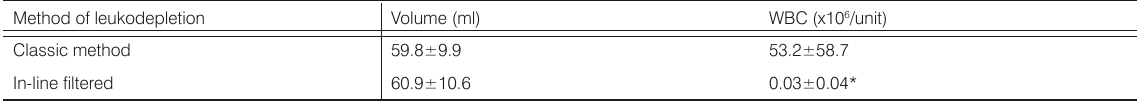
Table 1. Volume and number of blood cells of final filtered components compared to nonfiltered units.